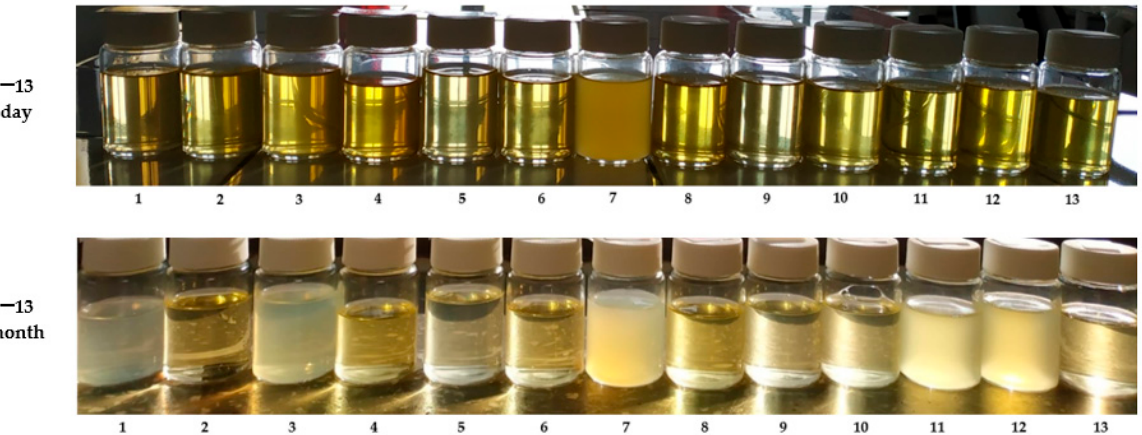
Figure 2. Photo capture of MELSA 1–MELSA 13 microemulsions at one day after preparation—case ( a ), and after one month—case ( b ), visualized at room temperature, 25 ± 0.5 °C.